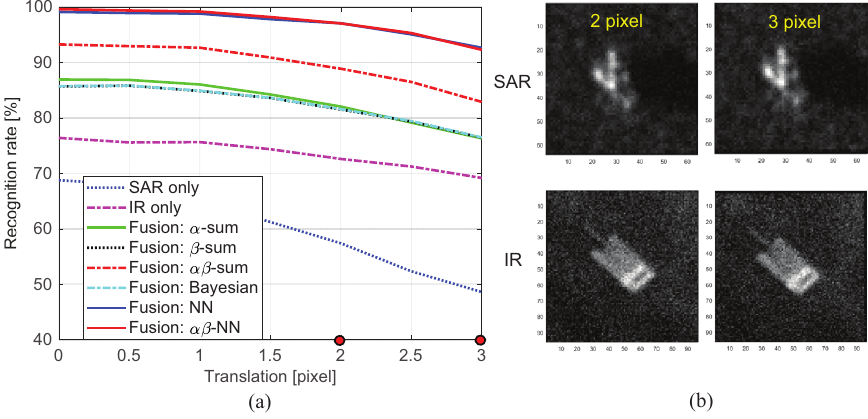
Figure 22. Performance evaluation results for the translational variation: ( a ) recognition rate vs. the translation level [pixel]; ( b ) test examples of SAR and IR images at different translation